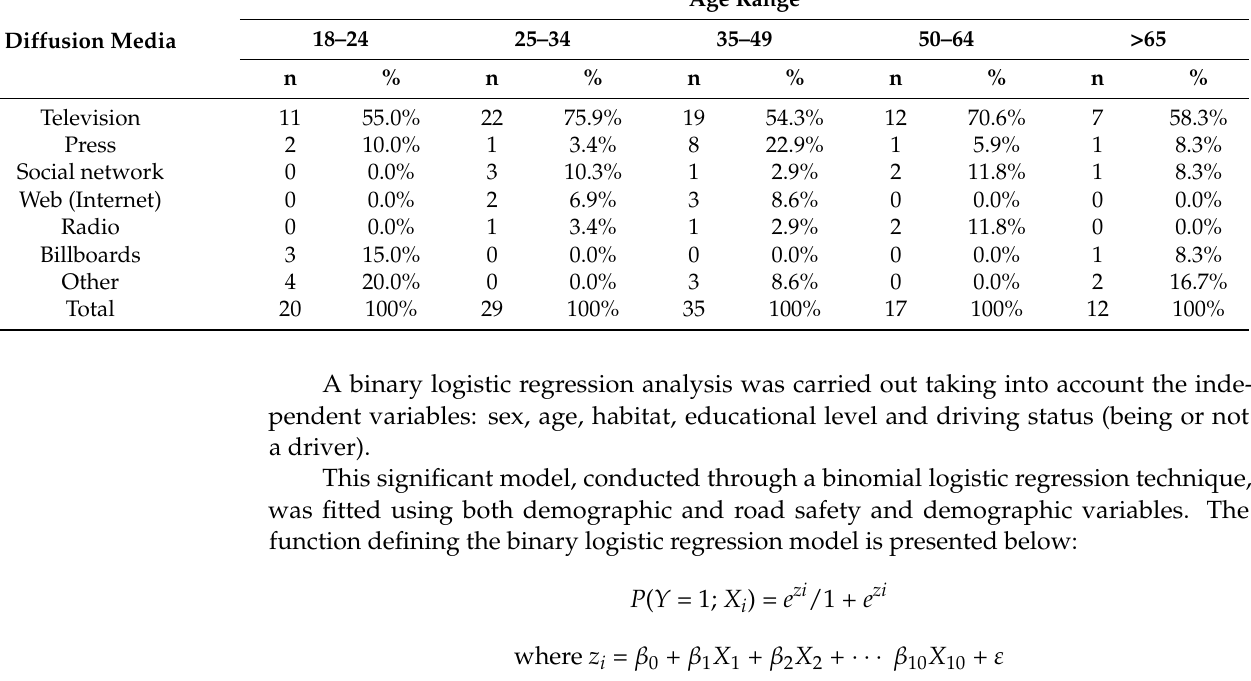
Diffusion Media